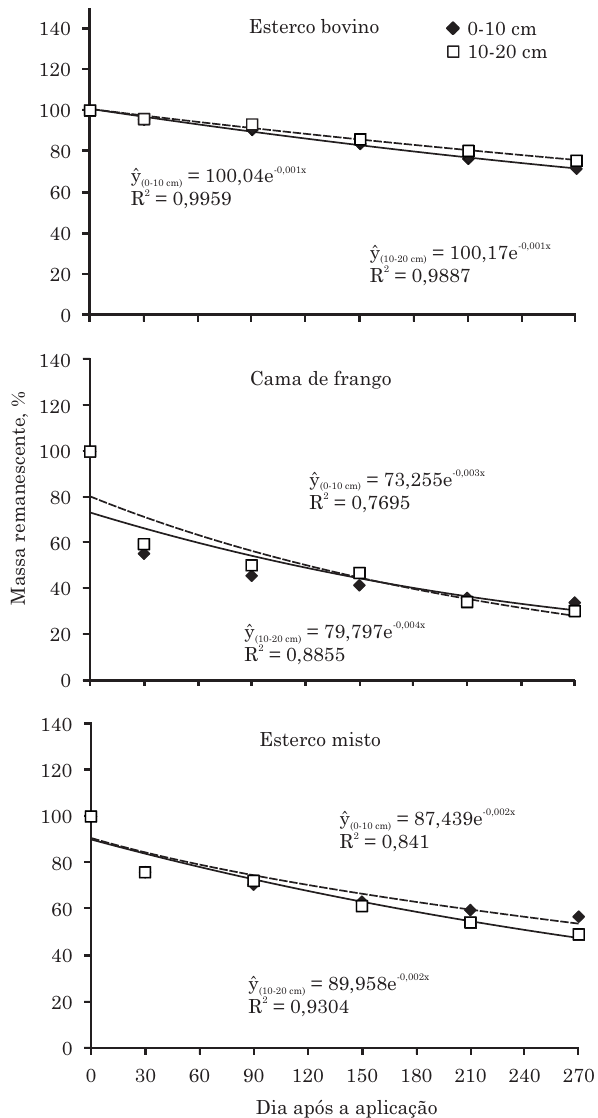
Figura 2. Massa remanescente de esterco bovino, cama de frango e esterco misto, nas camadas de 0-10 e 10-20 cm, em função dos períodos de